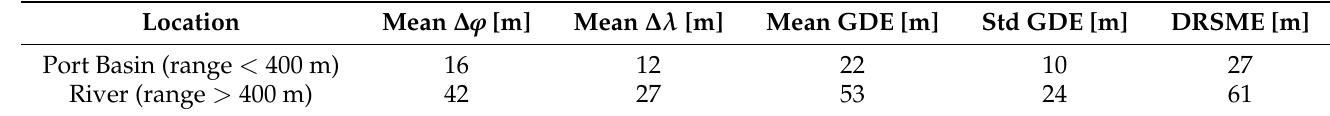
Table 5. Quantitative ship georeferencing results. ∆ ϕ and ∆ λ stand for absolute latitude and longitude error, respectively. GDE stands for georeferencing distance error. Std stands for standard deviation. DRSME stands for distance root-mean-square error.